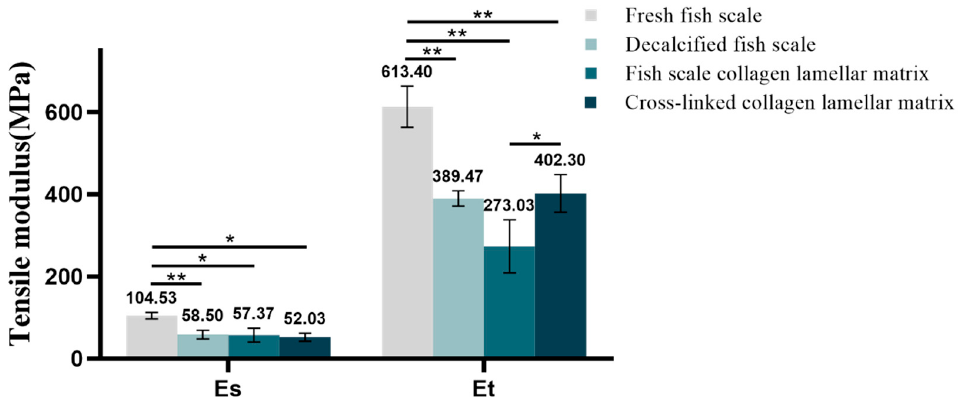
Figure 10. Tensile modulus for different samples ( n = 3). * p < 0.05; ** p < 0.01.